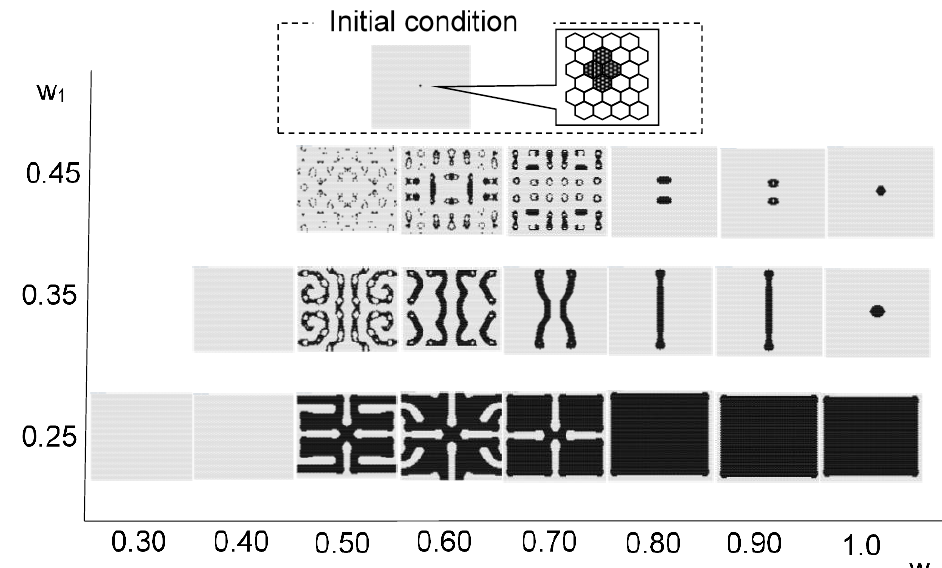
Figure 11. Results for the model with s = 5 and t = 9 in a hexagonal grid. The image of each w 1 and w 2 value is based on centrally arranged four black cells as shown in Figure 7. Instability became stronger as w 2 decreased. The initial central spotted pattern grew as an unstable wave in the field. When w 2 was relatively large, the central spot did not spread.